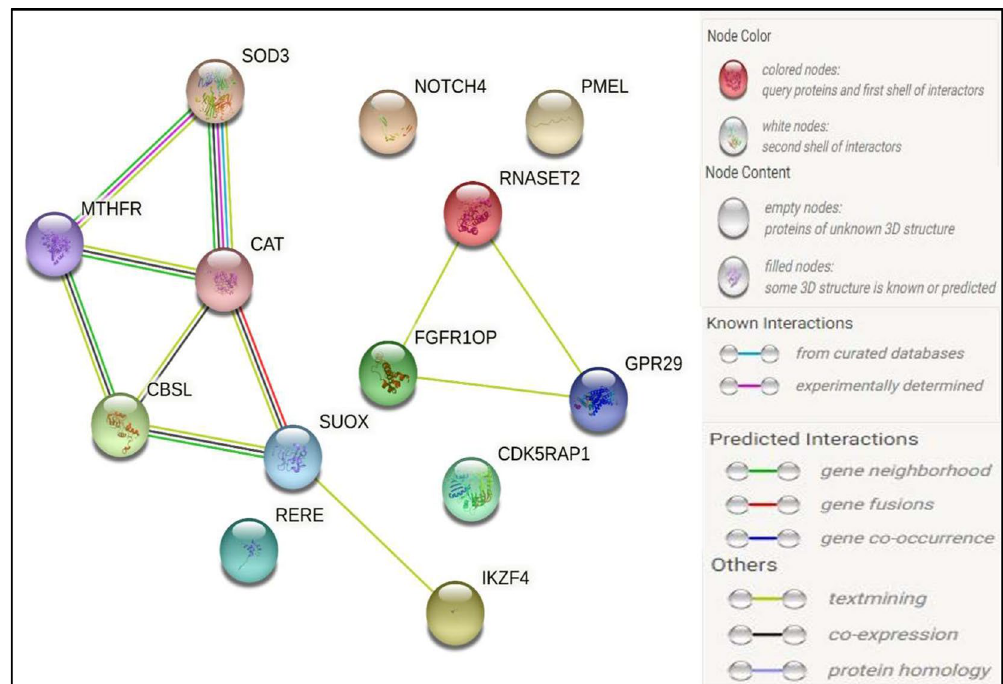
Figure 2. The figure illustrates the protein–protein interaction between the prioritized genes obtained from STRING